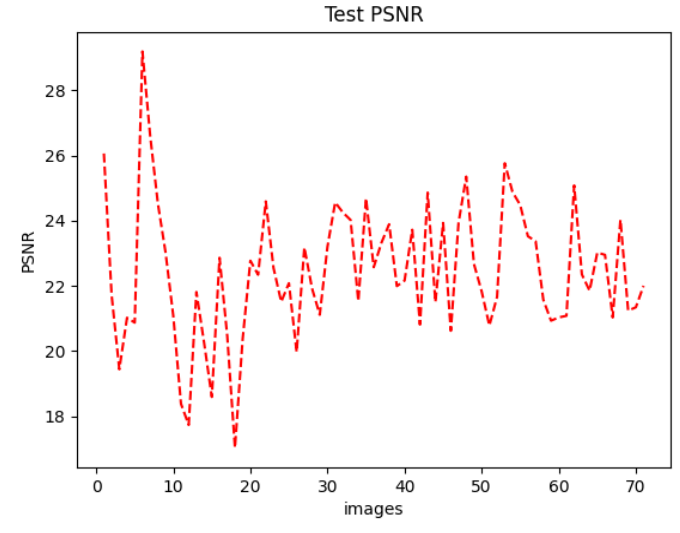
Figure 11. PNSR of the moiré